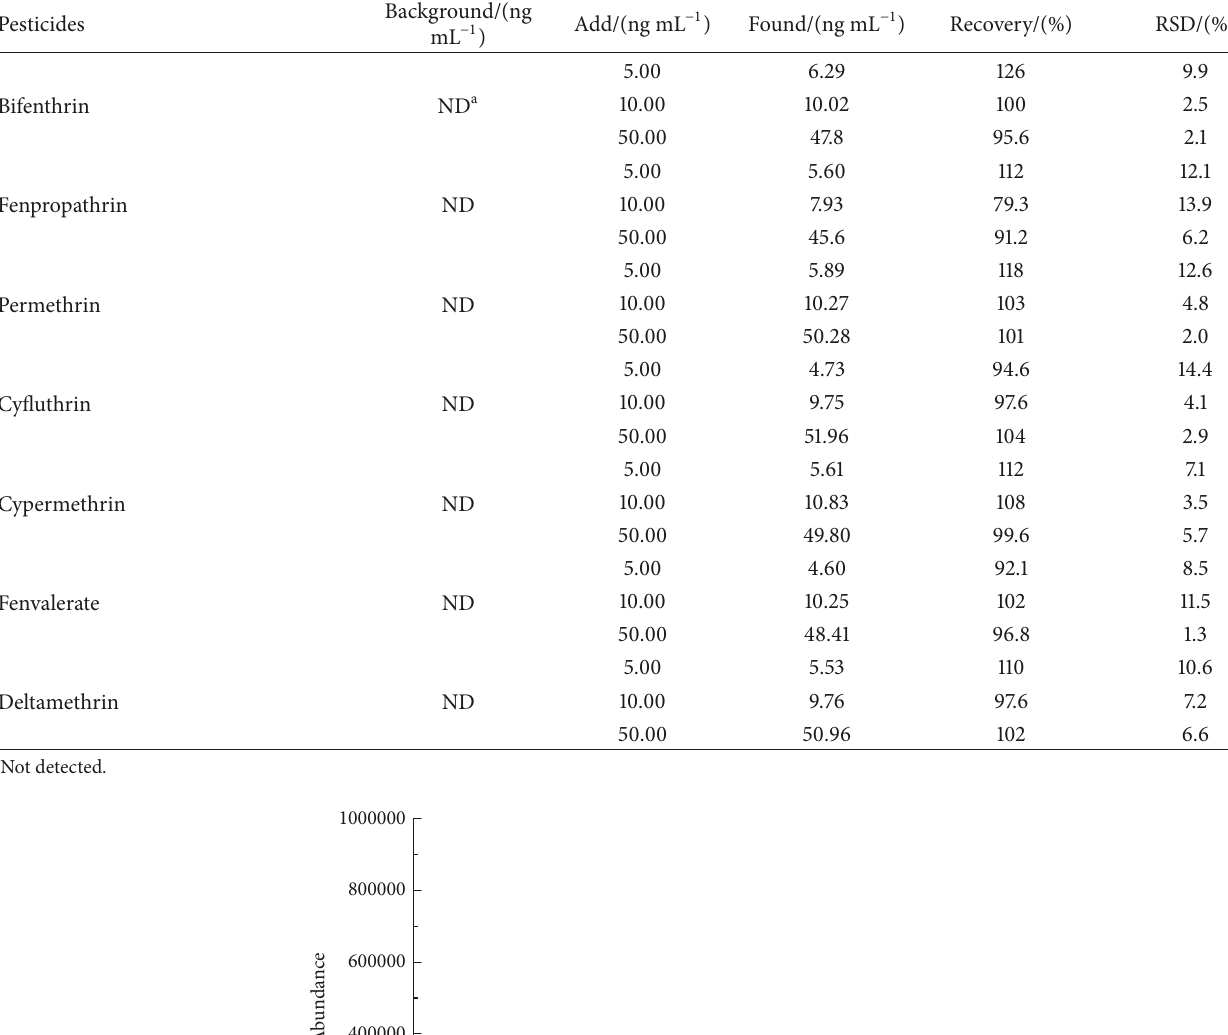
Table 3: The recovery and RSDs of the method.